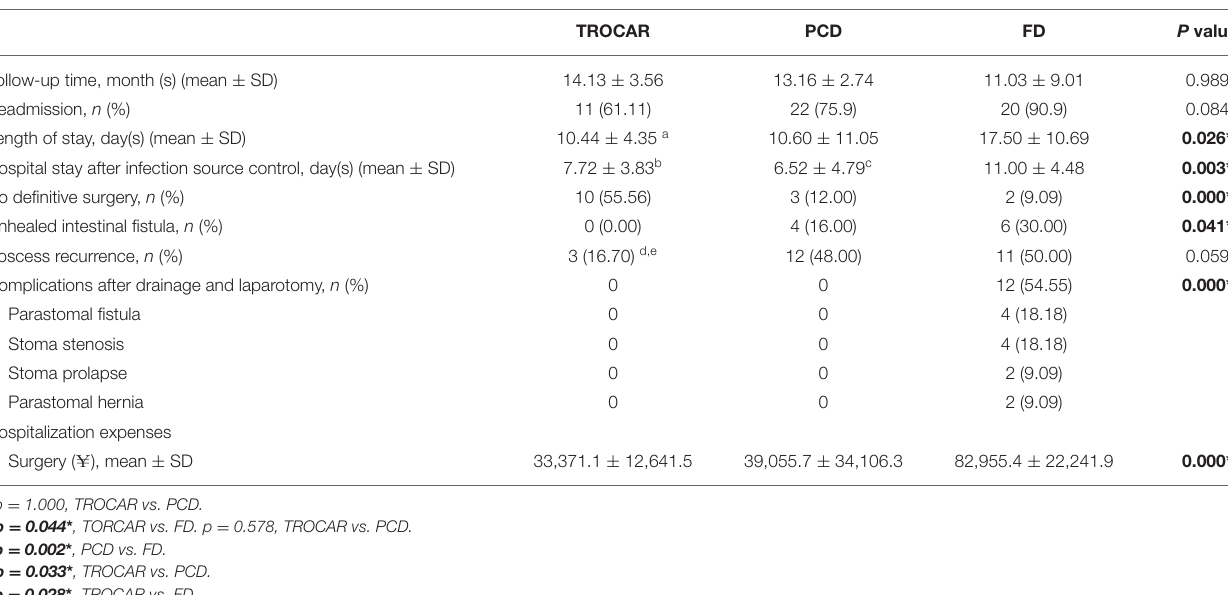
TROCAR PCD FD P value